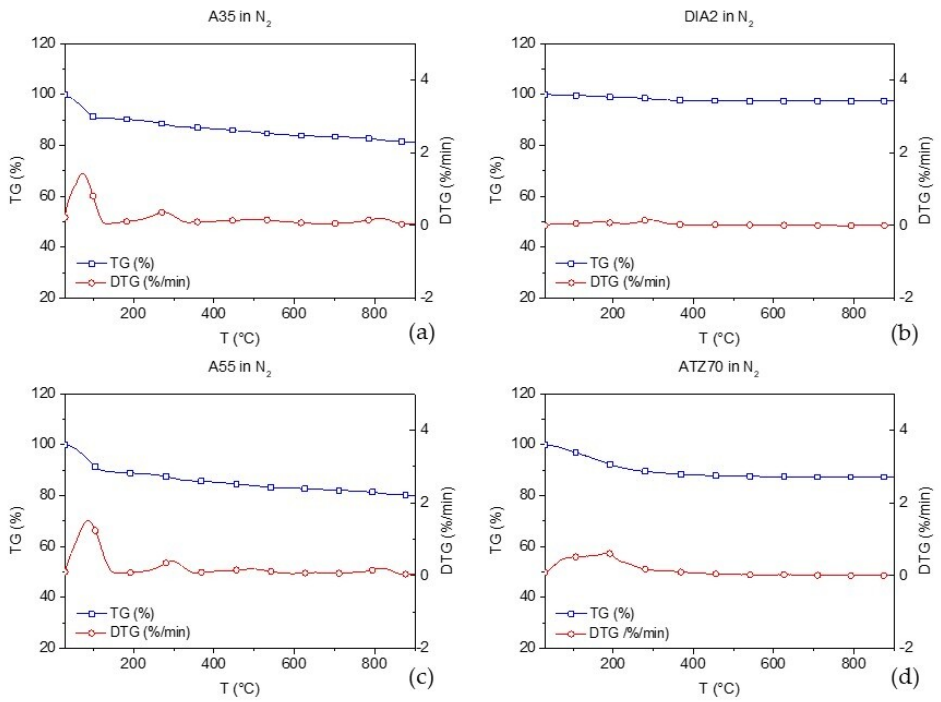
Figure 3. TG/DTG curves of the selected porous media: ( a ) Sepiolite A35, ( b ) Diatomite DIA2, ( c ) Sepiolite/Paligorskite A55 and ( d ) Zeolite ATZ70.